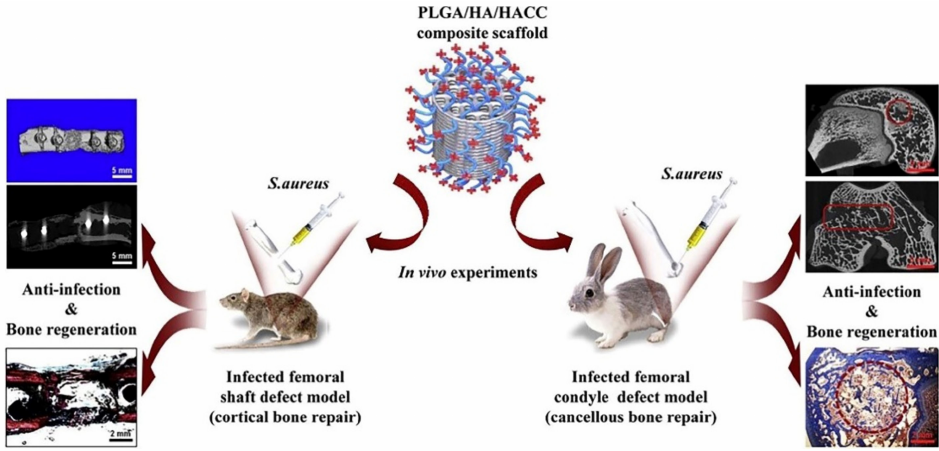
Figure 6. HACC–PLGA/HA composite scaffold in cortical bone defects in rats and hairy bone defects in rabbits [68]. Copyright 2018,